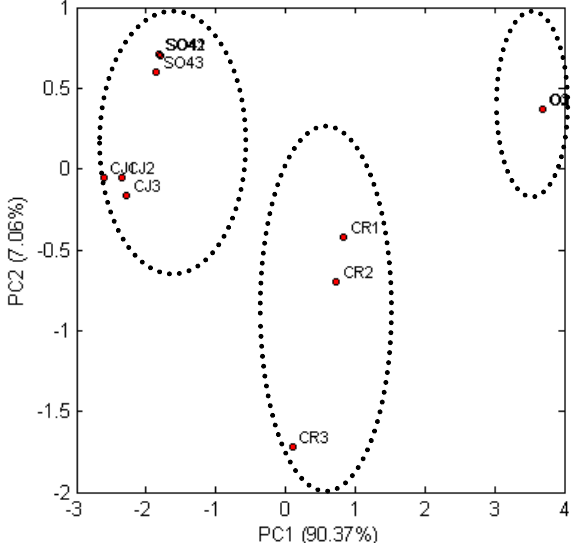
Figure 3. PCA scores plot of triticale straw pretreated with ionic liquid, recycled ionic liquid, sulfate method, untreated (control).